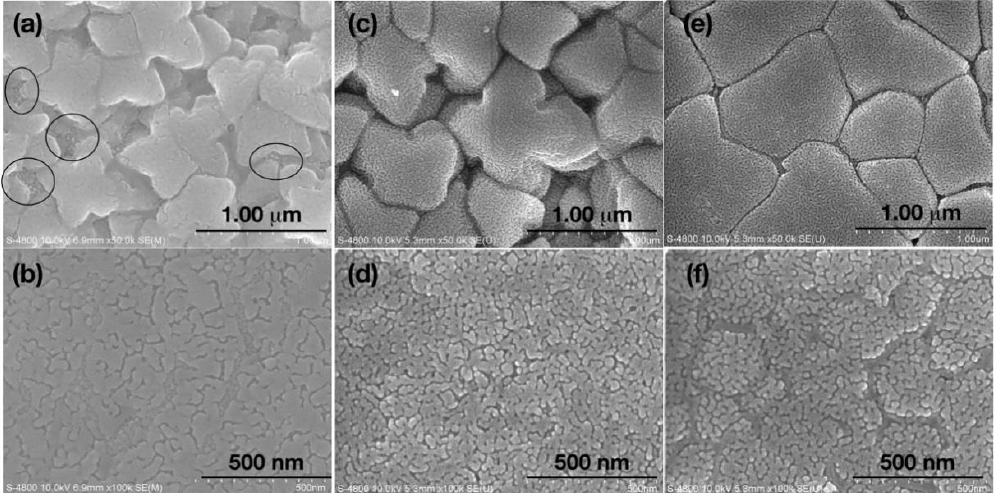
Figure 2. FESEM (field emission scanning electron microcopy) photographs of thick films developed by melt spinning. ( a , c , e ) are taken on the free side of films SAT-5, SAT-10 and SATS-10, respectively. ( b , d , f ) are taken on the wheel side of films SAT-5, SAT-10 and SATS-10, respectively. Small Ag 2 Te particles in image ( a ) were labeled by ovals. All images were collected on films without any processing or treatment after melt spinning.